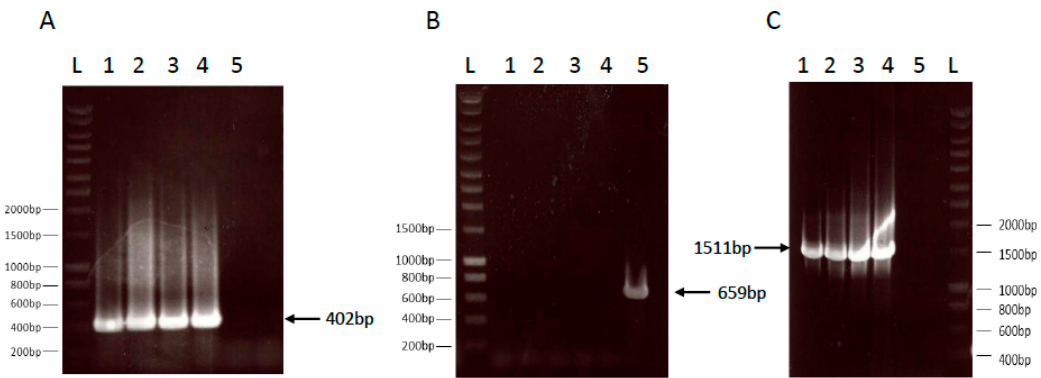
Figure 1. PCR analyses of the ampG and dnt loci of the lyophilized BPZE1 drug product compared to the liquid drug product. E. coli ampG (panel A ), B. pertussis ampG (panel B ) and the B. pertussis dnt flanking regions (panel C ) of two lots of the liquid BPZE1 drug product (lanes 1 and 2) and two lots of the lyophilized BPZE1 drug product (lanes 3 and 4), as well as a BPSM control (lanes 5) were amplified by PCR using the appropriate primers listed in Table 1. Lanes L contain the molecular size markers with relevant sizes in bp indicated in the margins. The arrows point to the expected amplicons of 402 bp (panel A ), 659 bp (panel B ) and 1511 bp (panel C ) for E. coli ampG , B. pertussis ampG and the B. pertussis dnt flanking regions, respectively.